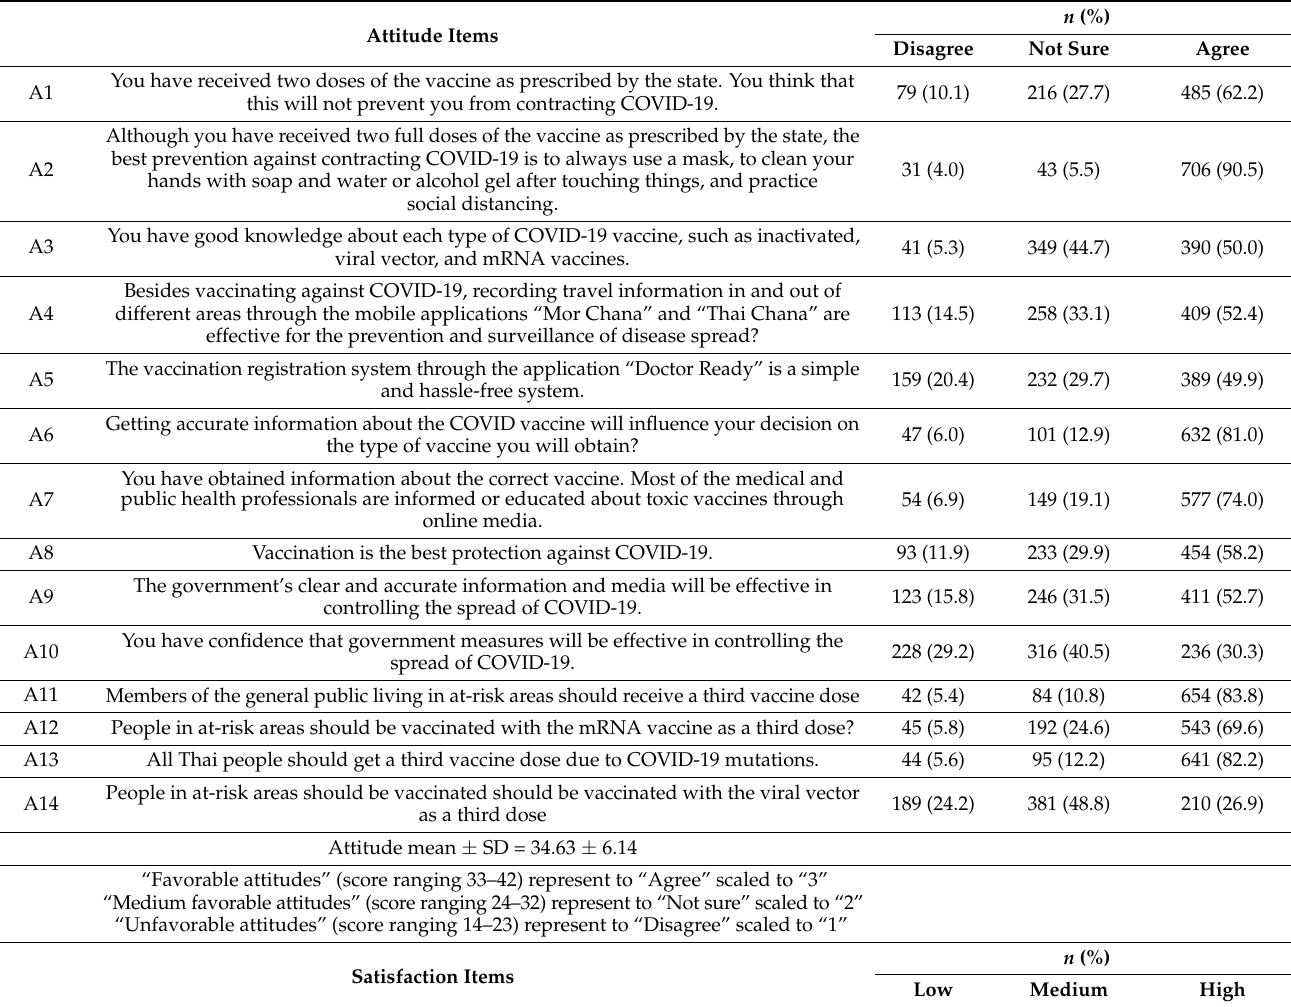
Table 2 for details). Table 2. Frequency scores for attitude and satisfactions